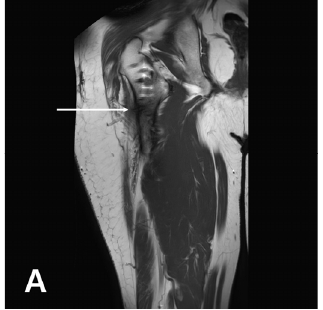
Figure 1. Magnetic resonance imaging (MRI) of the proximal thigh. ( A ) Linear signal intensity change in the lateral cortex of the subtrochanteric region in the T1-weighted image (white arrow); ( B ) T2-weighted STIR image revealed low signal intensity in the lateral cortex of the femur with trabecular edema (white arrow); ( C ) Sagittal image revealed focal low signal intensity in the T2-weighted image (white arrowhead).